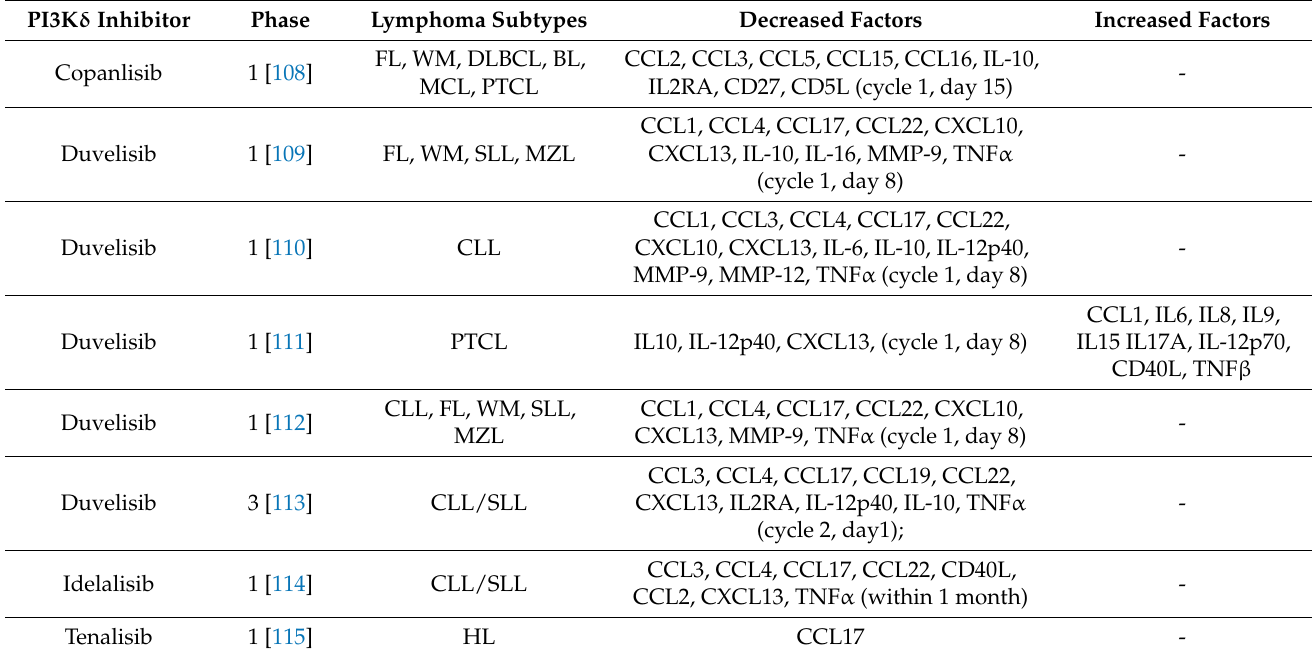
Table 2. Effect of the PI3K δ inhibitors on serum levels of secreted factors in the context of clinical trials enrolling patients with